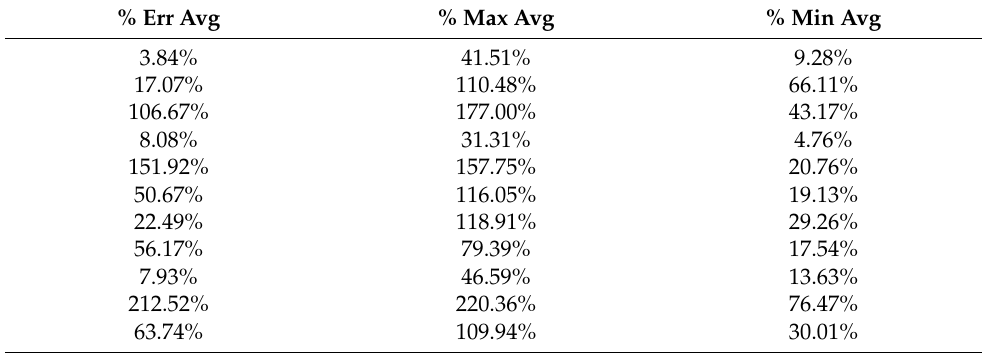
Table A181. Set 3, trials 11–20 data (actual PR value).